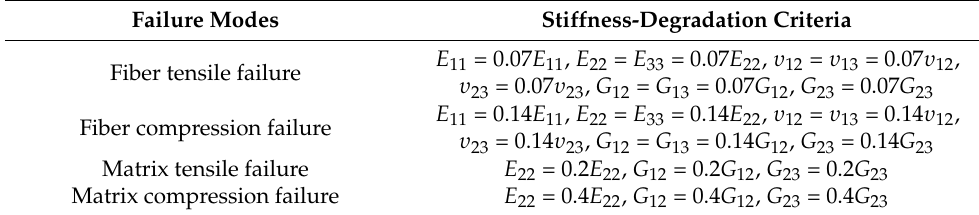
Table 7. Stiffness-degradation criteria of composite materials.